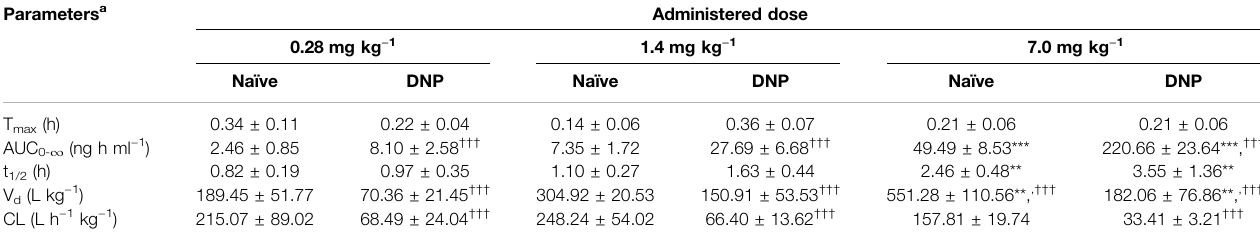
TABLE 1 | Non-compartmental PK parameters after the oral administration of KM (0.28, 1.4, or 7.0 mg kg − 1 ) in naïve and STZ-induced DNP rats ( n (cid:2) 6). Parameters